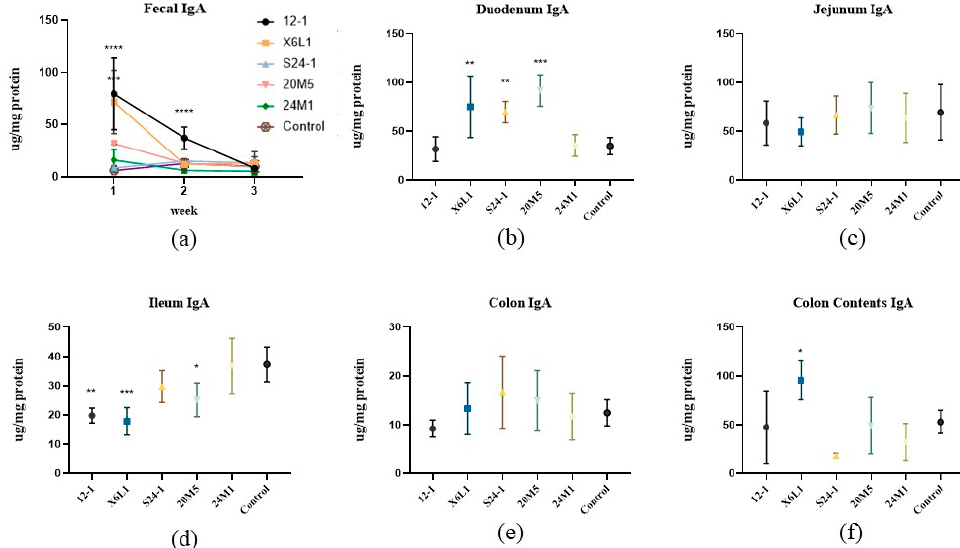
Figure 2. Effect of L. fermentum on IgA concentration in faeces and intestinal tract of normal mice ( a ) IgA in one to three week faeces; ( b – f ) Duodenum, jejunum, ileum, colon and colon contents were detected after three weeks by ELISA, “*” indicates p < 0.05, and “**” indicates p < 0.01, “***” indicates p < 0.001, “****” indicates p < 0.0001 (compared with control group). An immunofluorescence assay on paraffin sections of mouse intestinal segments showed that IgA in plasma cells was sporadically distributed in the duodenum and colon, compared with the control group. IgA was also observed in the jejunum and ileum, but the number of plasma cells was low (Figure 3a,b). There was no difference in the fluores- cence intensity of IgA and plasma cells in the jejunum. The IgA content in the intestinal segments was different among the groups and decreased with the direction of intestinal peristalsis. As shown in Figure 3b, compared with the control group, the fluorescence in- tensity of IgA in different intestinal segments of Lactobacillus -treated mice were different. The IgA plasma cell content in the duodenum was significantly higher than that in the other intestinal segments. X6L1 and 20M5 significantly increased the immunofluorescence intensity of IgA plasma cells in the duodenum. In the ileum, 12-1 and X6L1 decreased the fluorescence intensity. X6L1, S24-1, 20M5 also reduced the immunofluorescence intensity of IgA plasma cells in the colon.